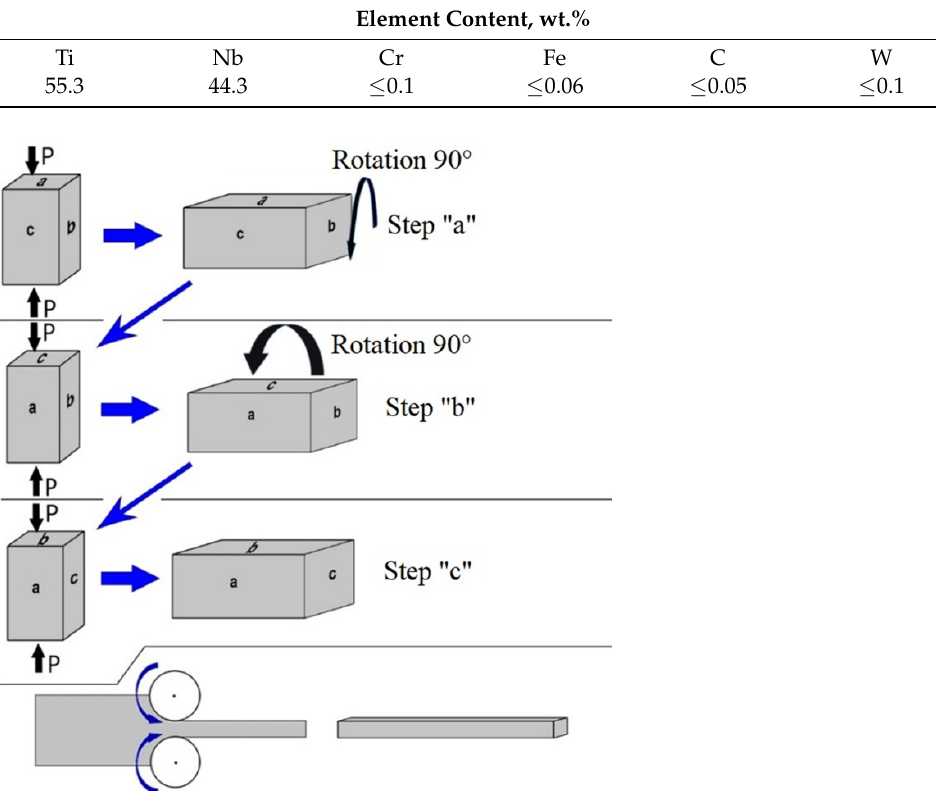
Figure 1. Multidirectional forging, including rotation of the deformation axis (abc-forging) and further rolling in grooved rollers.